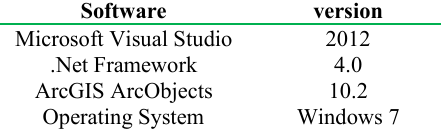
Table 1. Details of the development environment